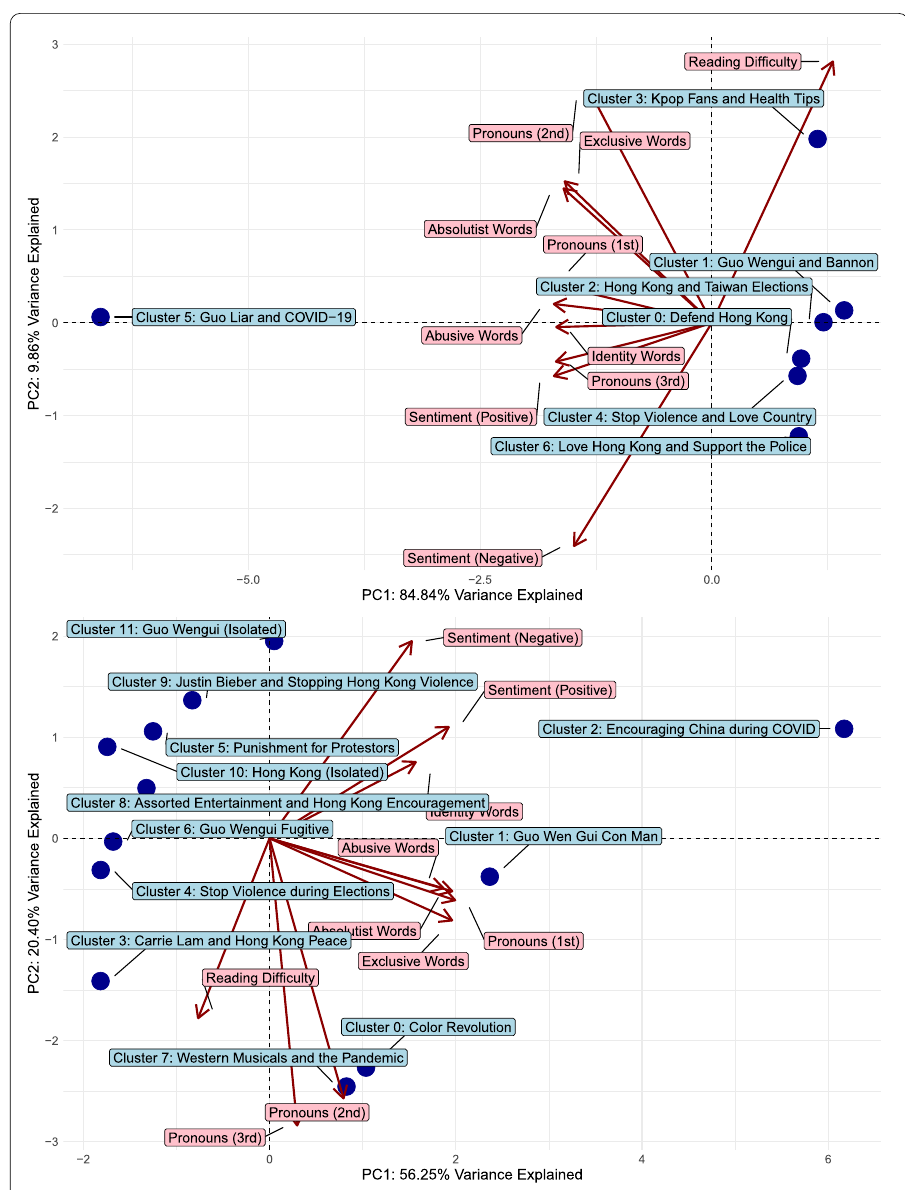
Figure 6 Two-dimensional visualization of variation in cluster-level psycholinguistic features based on PCA. Blue points depict the coordinates of account clusters based on the first two principal components. Red rays depict vector of each psycholinguistic feature based on the first two principal components. Top: PCA results in Era 1. Bottom: PCA results in Era